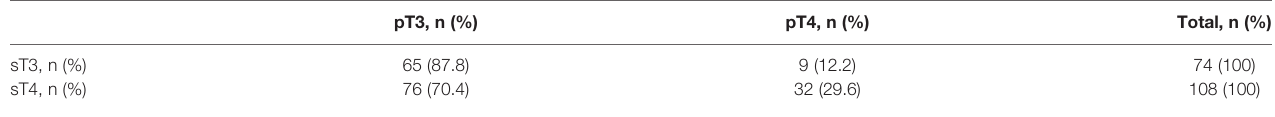
TABLE 5 | Distribution of the pathologic T3, 4 stages and the surgical T3, 4 stages in all pathologic TNM stages of right colon cancer. pT3, n (%) pT4, n (%) Total, n (%) sT3, n